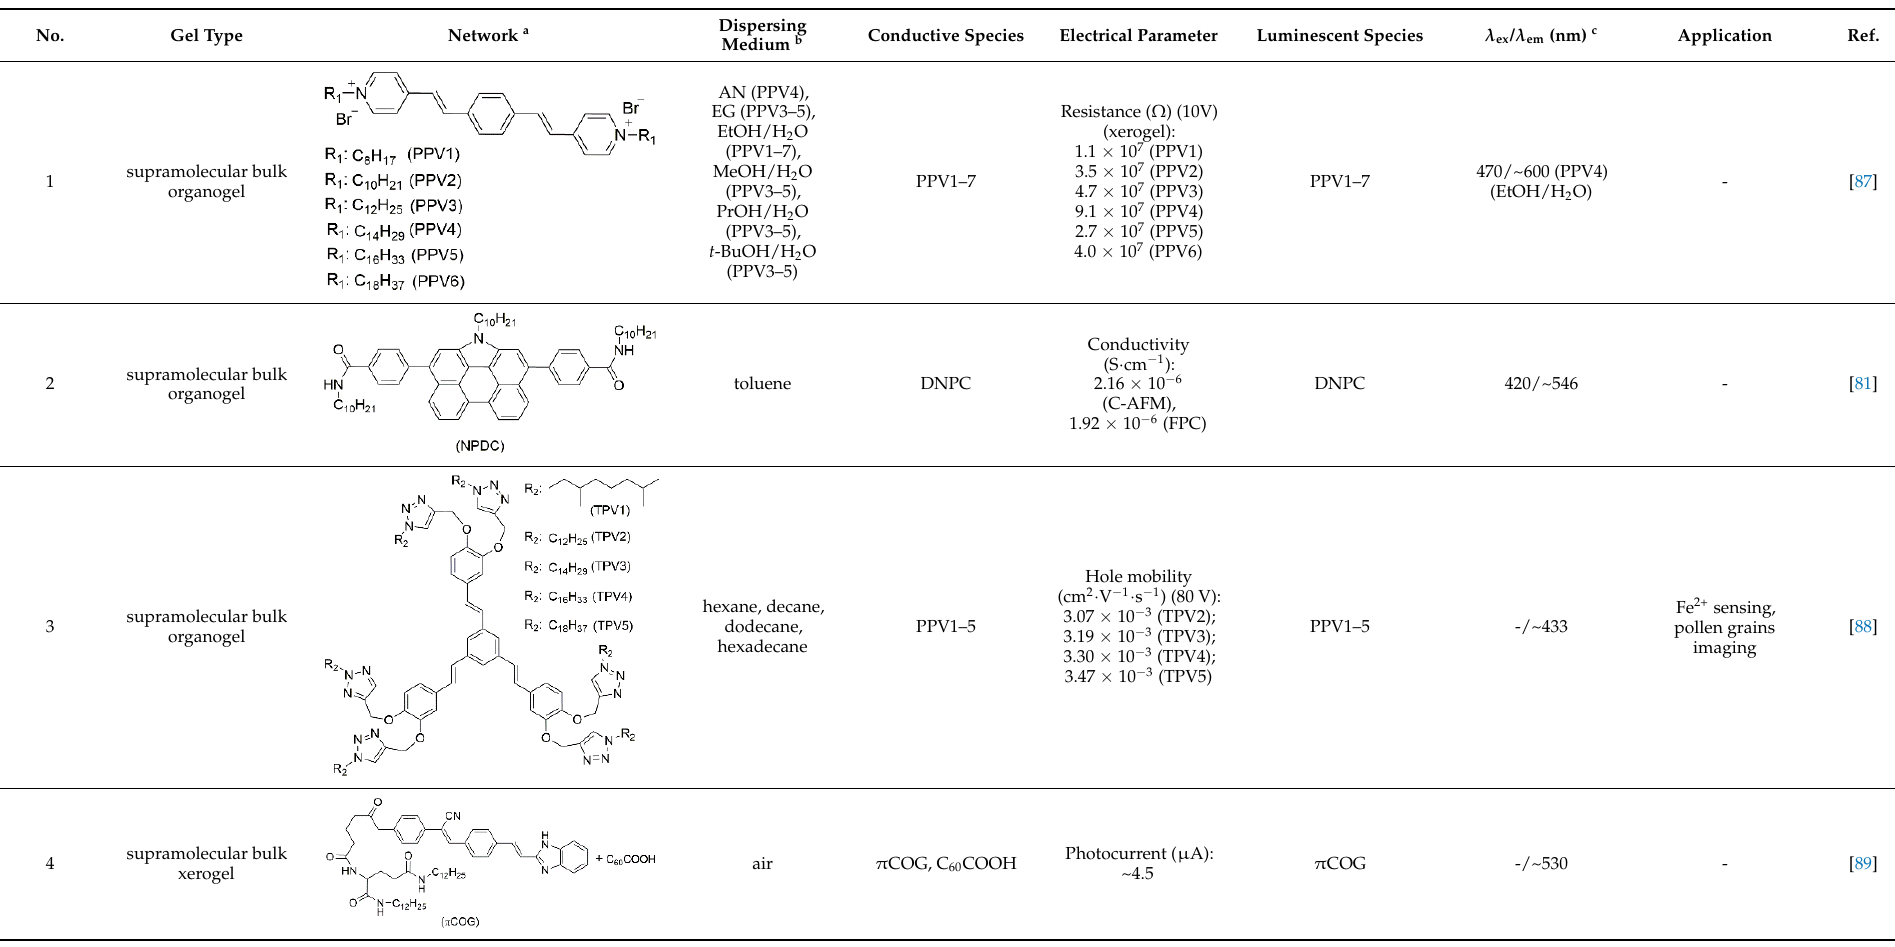
Table 1. Summary of information of typical luminescent conductive gels involved in this review.